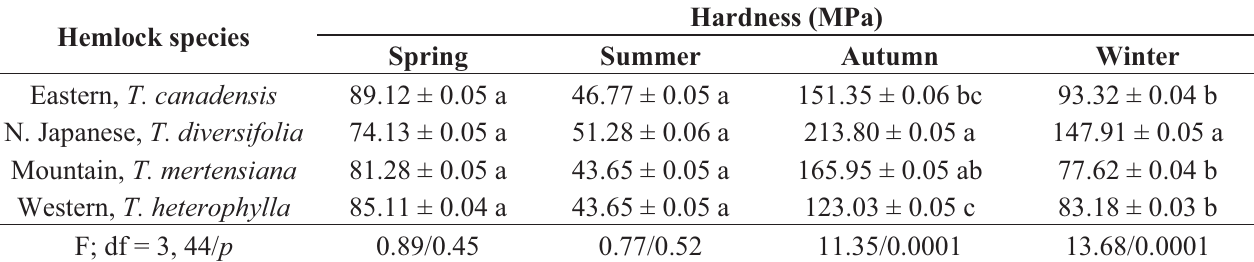
Table 3. Hardness (mean ± s.e.) of the hemlock woolly adelgid feeding stylet insertion point of four Tsuga species across four seasons. Means separation performed on log-transformed data; means within columns followed by the same letter do not differ ( p <